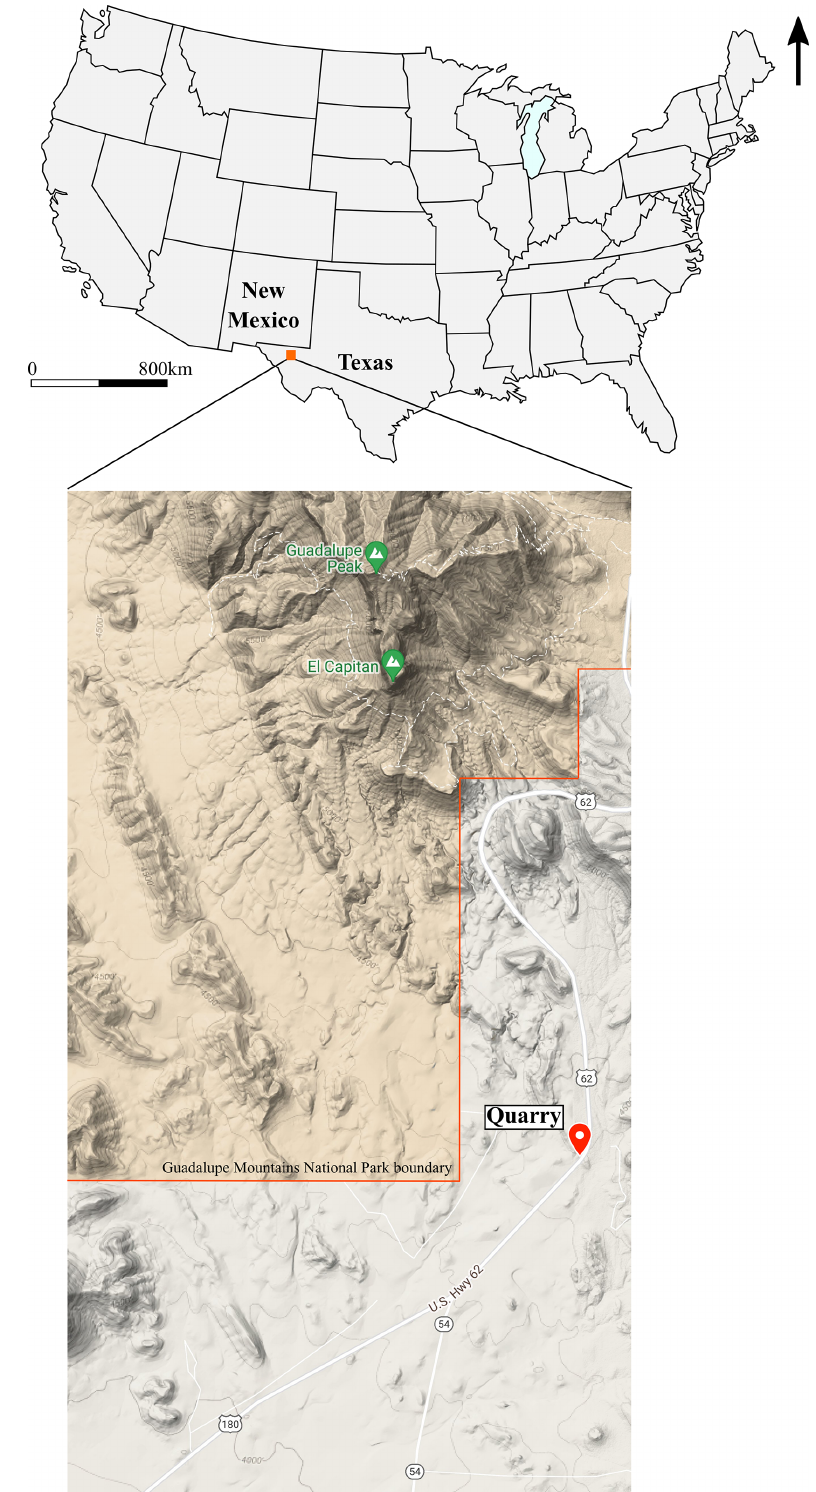
Fig. 3. A . Location of Texas in the USA. B . Location of the studied sections along US Highway 62/180 in the Guadalupe Mountains, West Texas (Google Maps 2021). The orange area shows the Park and its boundary. The section MKSC1 is located within the park but its precise position cannot be disclosed because of park